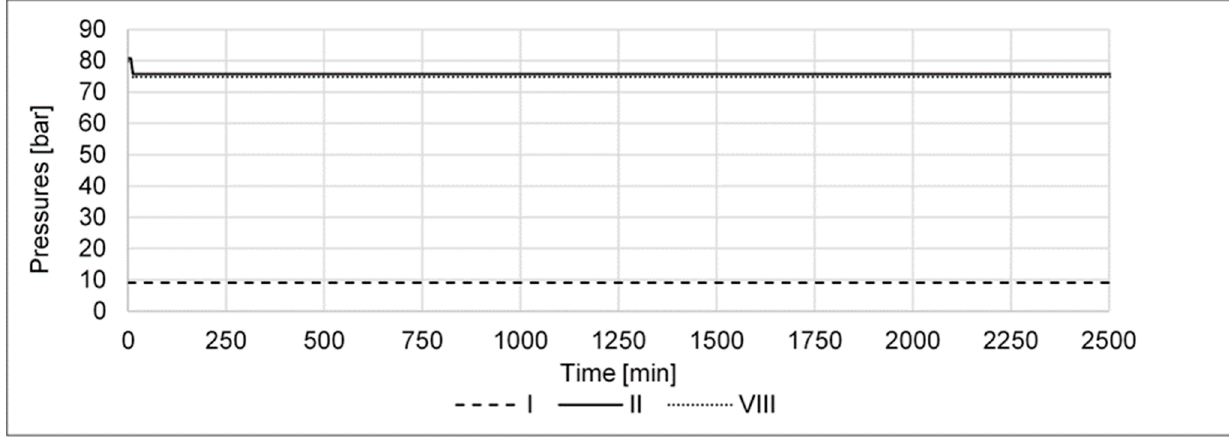
Figure 14 . Selected pressure values of scenario (f). Figure 14. Selected pressure values of scenario (f).